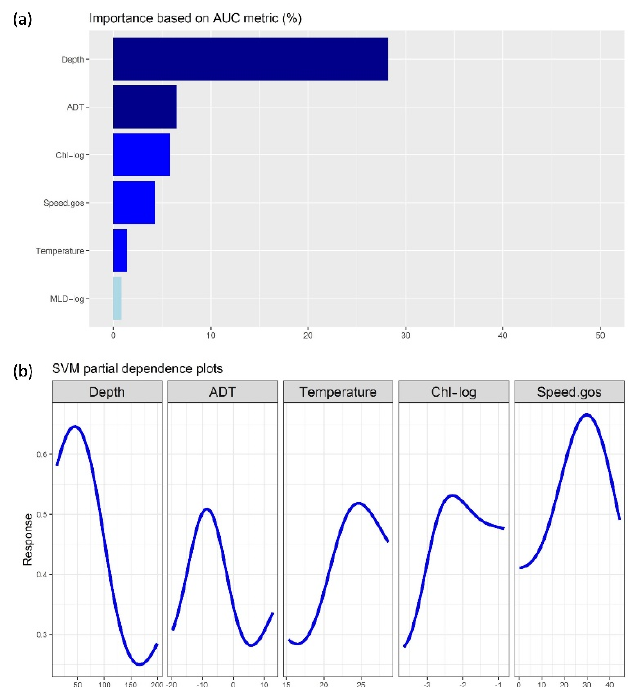
Figure 5. BRT results: ( a ), barplots of variable importance scores based on AUC-metric. The dark blue, blue and light blue colored bars indicate variables with high significance ( p -value < 0.01), moderate significance (0.01 ≤ p -value < 0.05) and no significance ( p -value ≥ 0.05), respectively. ( b ), partial plots of significant ( p < 0.05) parameters are shown.